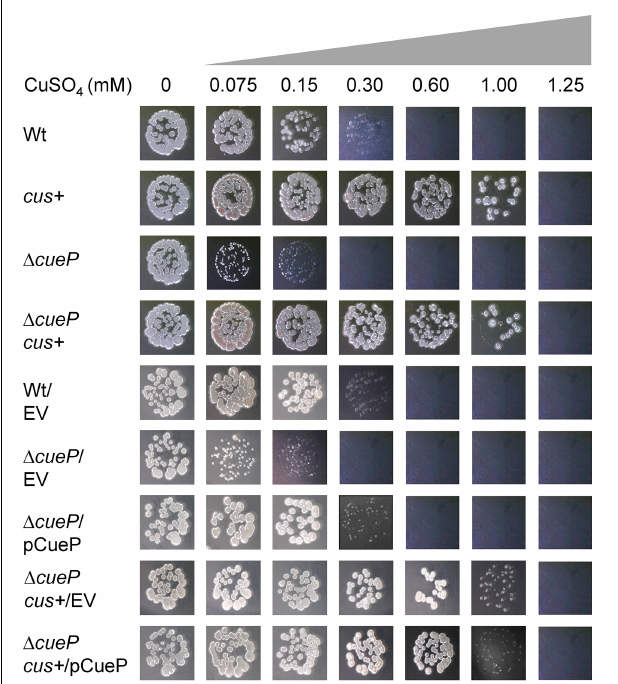
FIGURE 4 | The Escherichia coli cus locus increases Salmonella tolerance to Cu under anaerobic conditions. Comparative Cu MIC values of wild type (Wt), transgenic cus +, (cid:49) cueP , or (cid:49) cueP cus + Salmonella strains on Luria–Bertani broth plates containing increasing amounts of CuSO 4 in anaerobic conditions. The figure also shows the same strains harboring the vector plasmid pUH21-2 lacI q (EV) or pUH21-2 lacI q -based pCueP plasmid (pCueP). After incubation at 37 ◦ C for 24 h, the plates were photographed. The data correspond to representative images of at least three independent experiments done in duplicate.